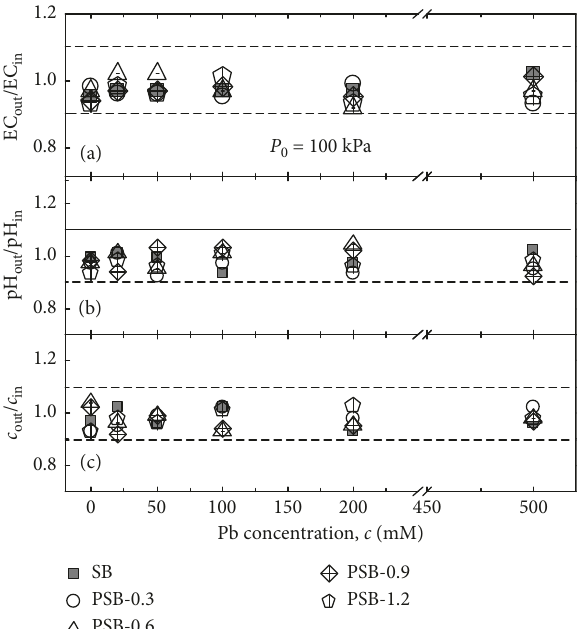
Figure 4: The properties of effluent leachate: (a) EC pH out /pH in , and (c) c out / c in